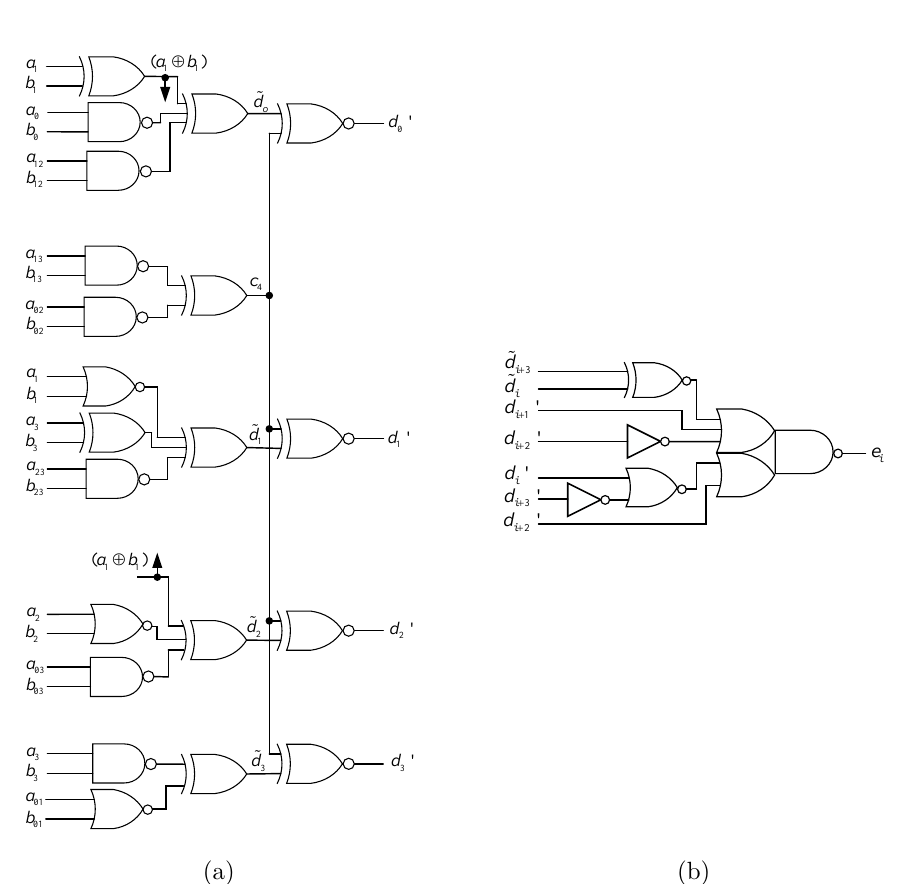
Figure 6: The least-area synthesized architectures from the behavioral modeling of (a) The exponentiation computation block using 3-input XOR gares. (b) The subfield inverter block using an OAI32 (OR-AND-Invert) compound